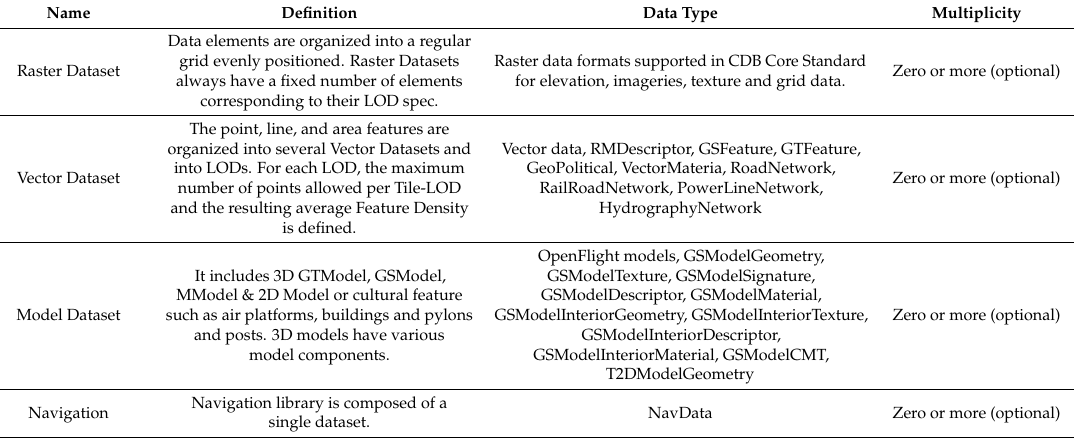
Table 2. The main properties of the UML diagram of the OGC CDB general data